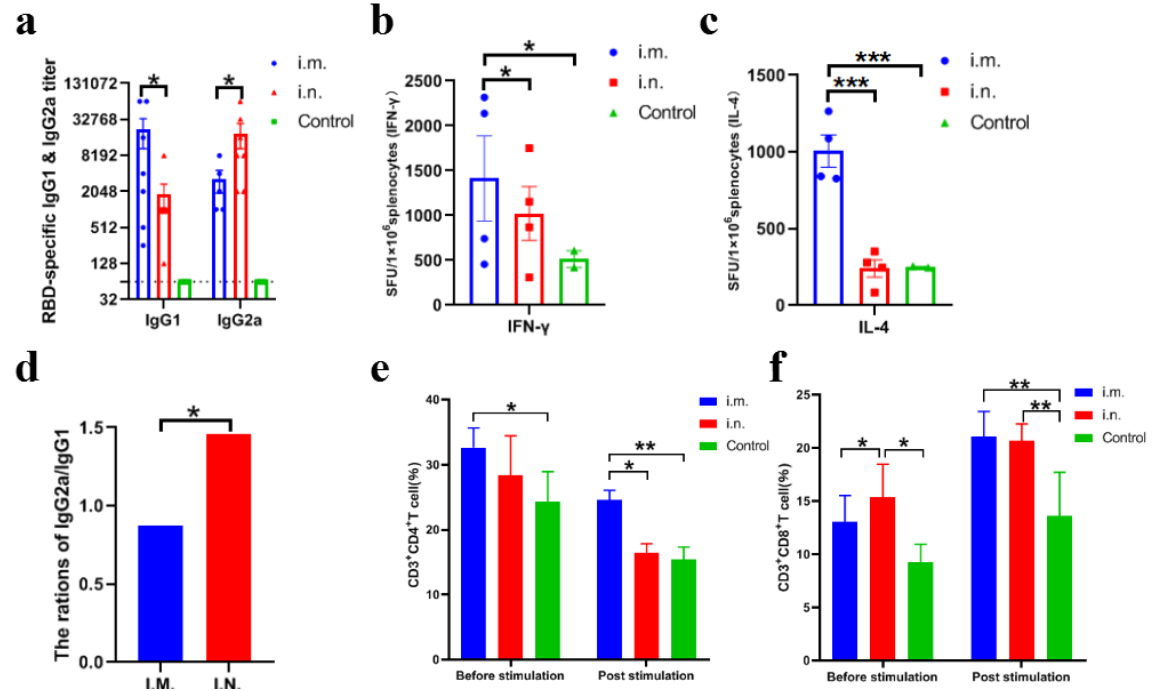
Figure 3. Antibody subtype and cytokines induced by rVSVΔG-S in BALB/c mice. I.m., i.n. and control refer to i.m. ( n = 4), i.n. inoculation group ( n = 4) and PBS inoculation control group ( n = 2), respectively (same in Figure 3b–f). ( a ) RBD-specific IgG1 and IgG2a induced by the rVSV vaccine in mice. ( b , c ) Splenocyte IFN- γ and IL-4 induced by the rVSV vaccine in mice. ( d ) Ratio of IgG2a/IgG1 in i.m. and i.n. group. ( e , f ) CD3+CD4+ and CD3+CD8+ positive T cell proportions in splenocyte